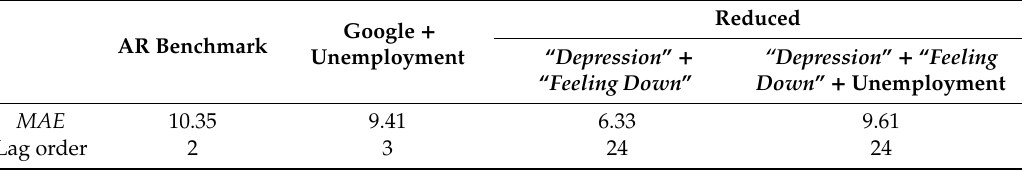
Table 3. Statistical models result for the benchmark and the VAR approach.